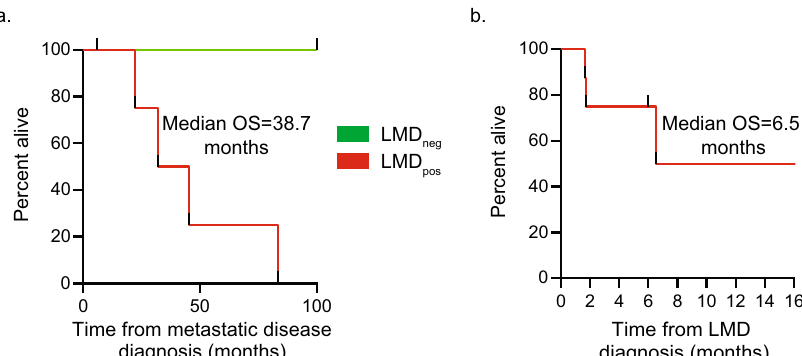
Fig. 1 Median overall survival from time of metastatic disease and LMD diagnosis. a Median overall survival from the time of metastatic disease diagnosis among patients with LMD (red) and those without LMD (green). b Median overall survival from the time of LMD diagnosis among the patients with LMD in